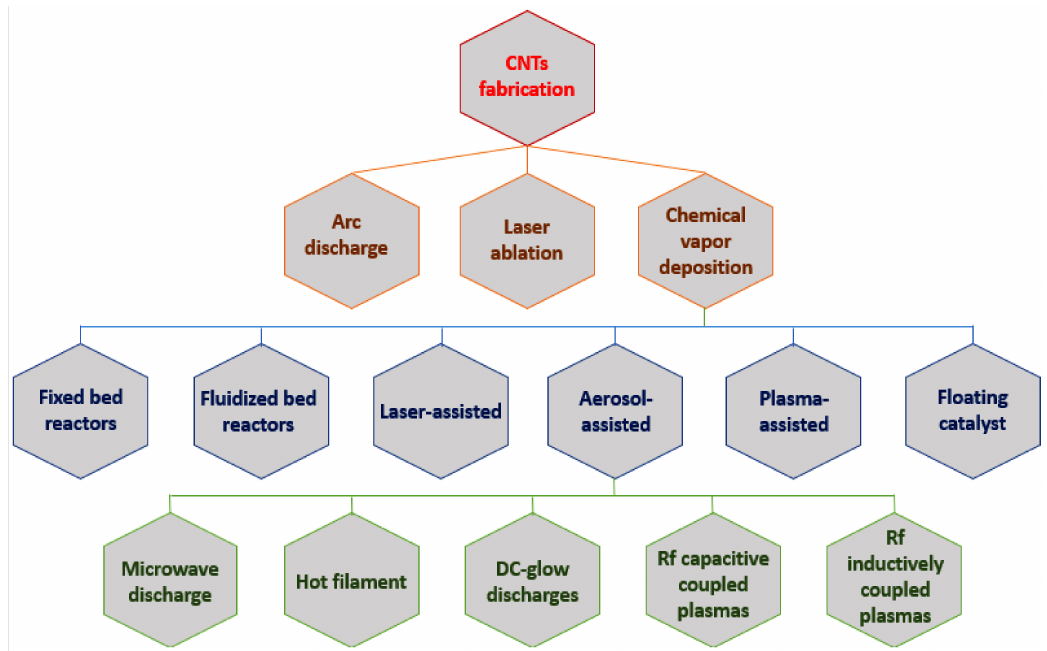
Figure 5. Fabrication methods of carbon nanotubes. Adapted from